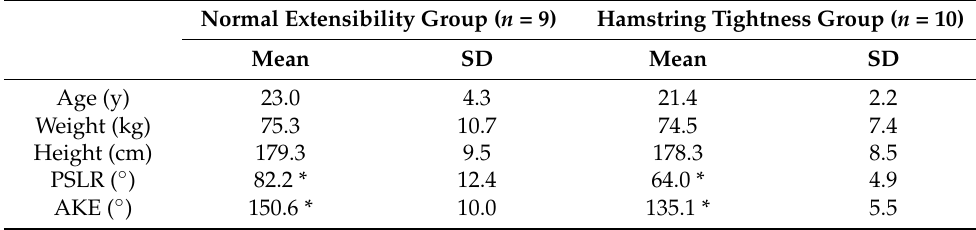
Table 1. Characteristics of the participants.